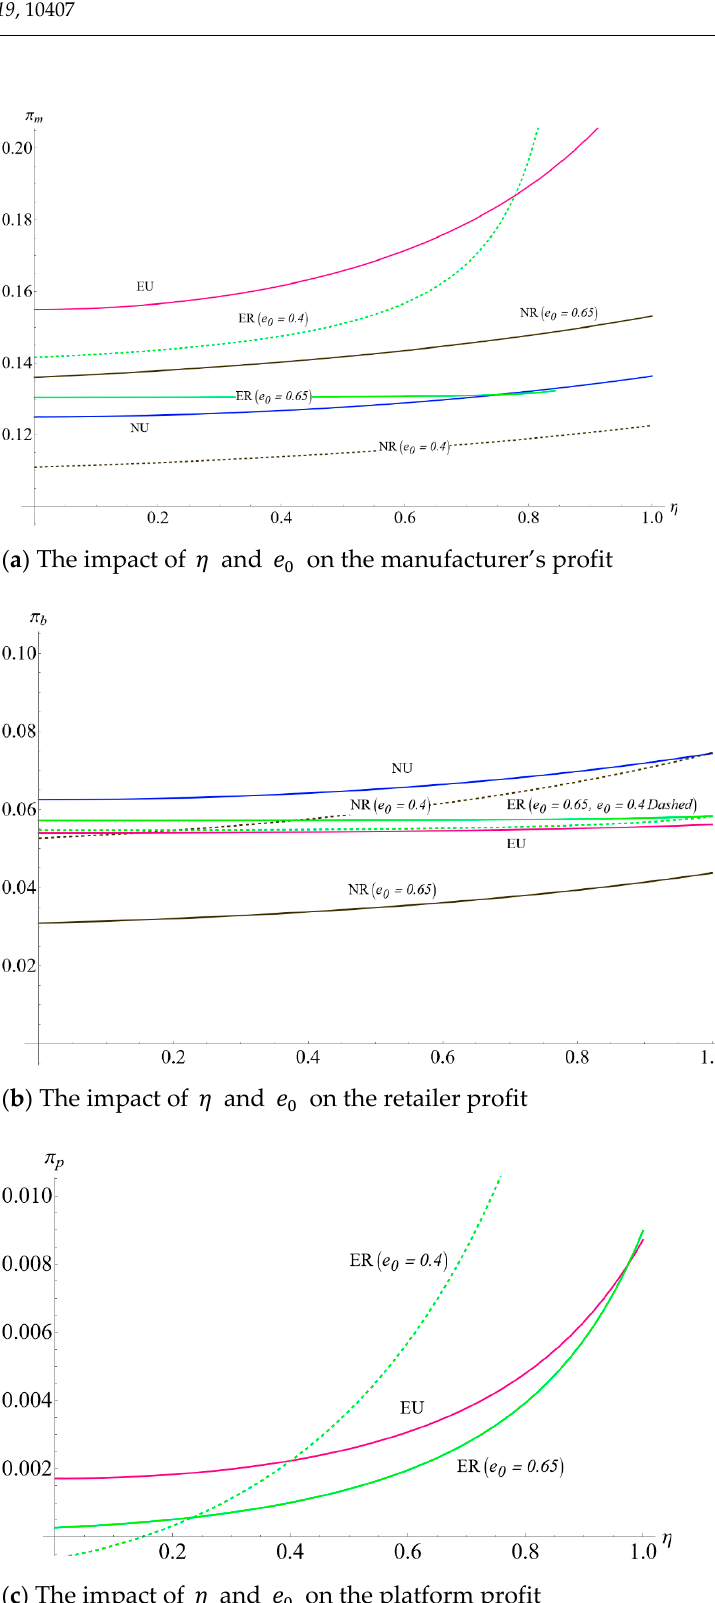
Figure 5. The impact of 𝜂 and 𝑒 (cid:2868) on operational decisions and